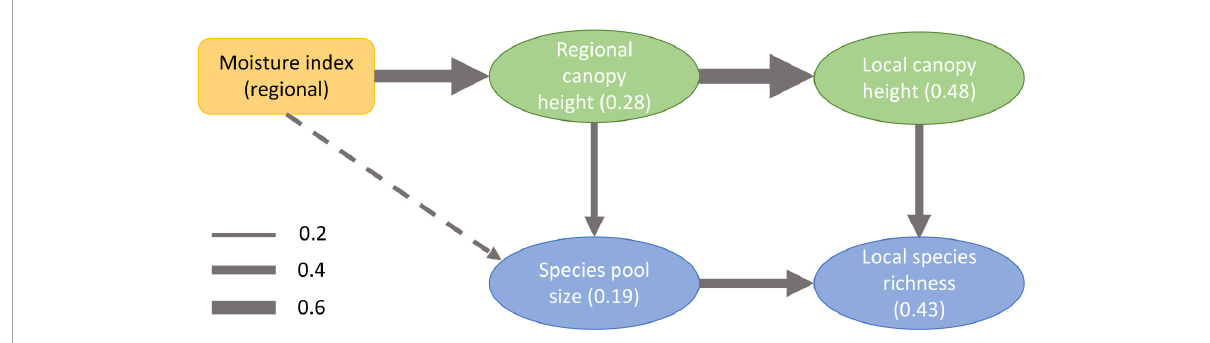
FIGURE3 Results of the multiscale structural equation model (Harrison and Cornell, 2008) relating species richness, pool size, canopy height, and water availability across spatial scales. Local scale is at the level of our study transects (length of 2 km). Regional scale is at the level of circles with a radius of 50 km centered at each transect. This figure shows observed local species richness and ecological species pool. Other options gave mutually consistent results (see Supplementary Figure 7 ). Arrow width is proportional to the standardized effect size (see the legend for values). Solid lines depict statistically significant effects, while hatched lines show effects with p -value > 0.05. Numbers in parentheses depict the proportion of variability explained ( R -squared